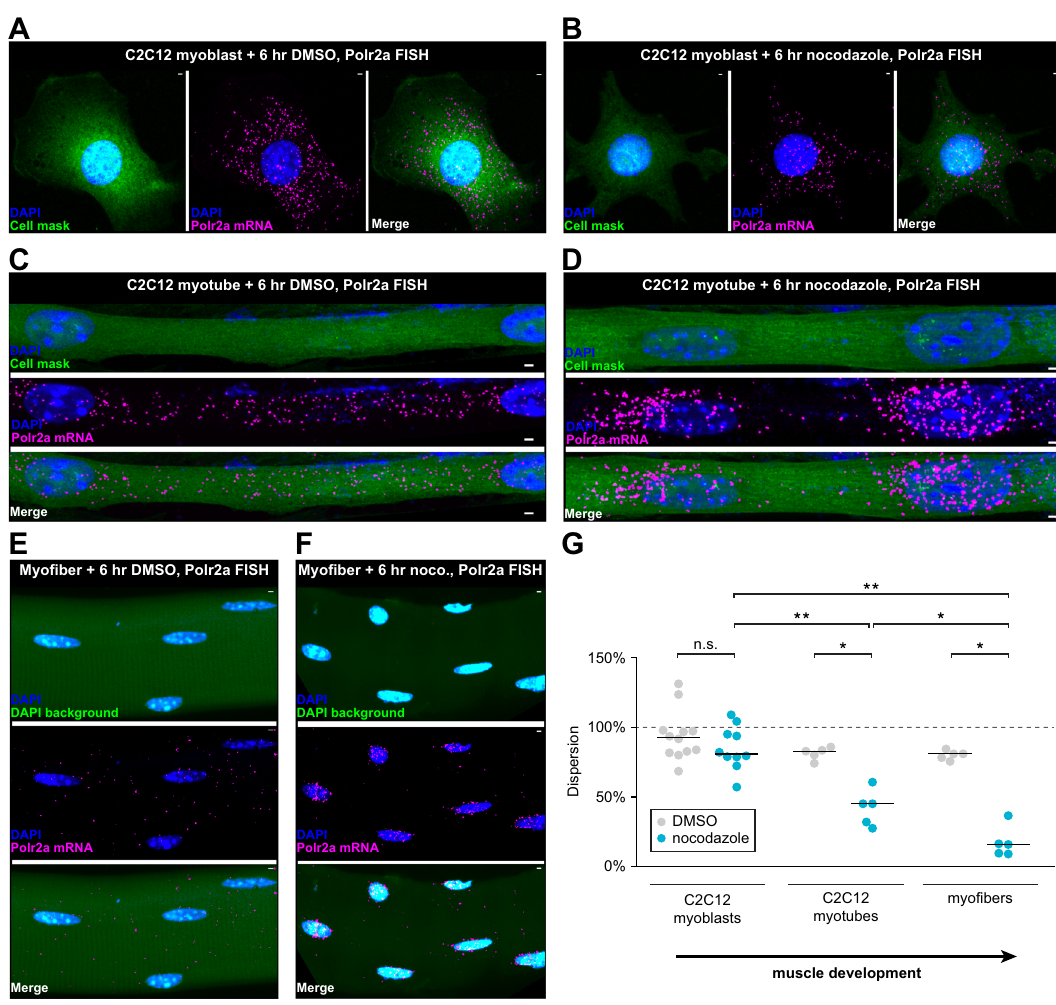
Fig. 5 Muscle development restricts microtubule-independent mRNA dispersion. A Polr2a FISH in C2C12 myoblast after 6 h control (DMSO) culture. Scale bars: 2 µ m. B Polr2a FISH in C2C12 myoblast after 6 h culture with nocodazole. Scale bars: 2 µ m. C Polr2a FISH in C2C12 myotube after 6 h control (DMSO) culture. Scale bars: 2 µ m. D Polr2a FISH in C2C12 myotube after 6 h culture with nocodazole. Scale bars: 2 µ m. E Polr2a FISH in myo fi ber after 6 h control (DMSO) culture. Scale bars: 2 µ m. F Polr2a FISH in myo fi ber after 6 hr culture with nocodazole. Scale bars: 2 µ m. G Percent dispersion for Polr2a RNA in C2C12 myoblasts, C2C12 myotubes, and isolated myo fi bers treated with nocodazole or control (DMSO) for 6 h. Black lines are medians. n = 5 myotubes and myo fi bers per condition. n = 10 and 12 cells for nocodazole and DMSO-treated myoblasts, respectively. * p < 0.05, ** p < 0.01, Two-sided Mann – Whitney U